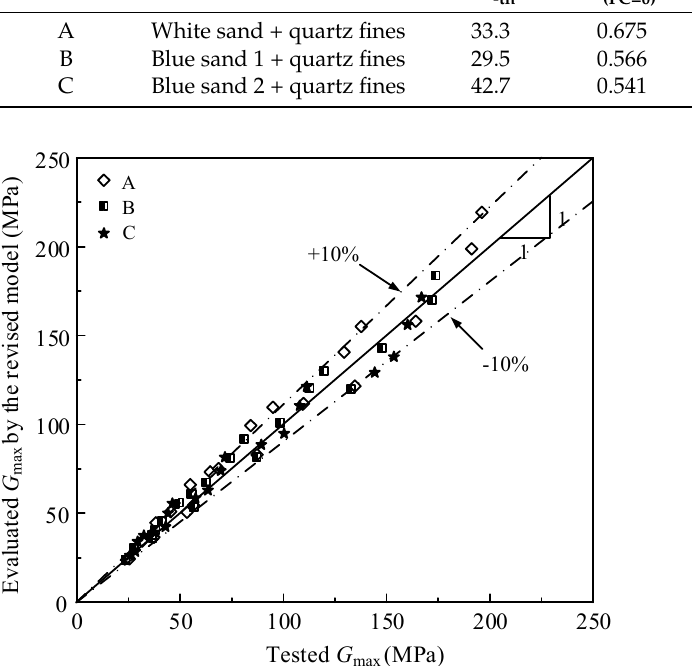
Figure 12. The relationship between the tested G max and evaluated G max by the revised model of Payan et al.